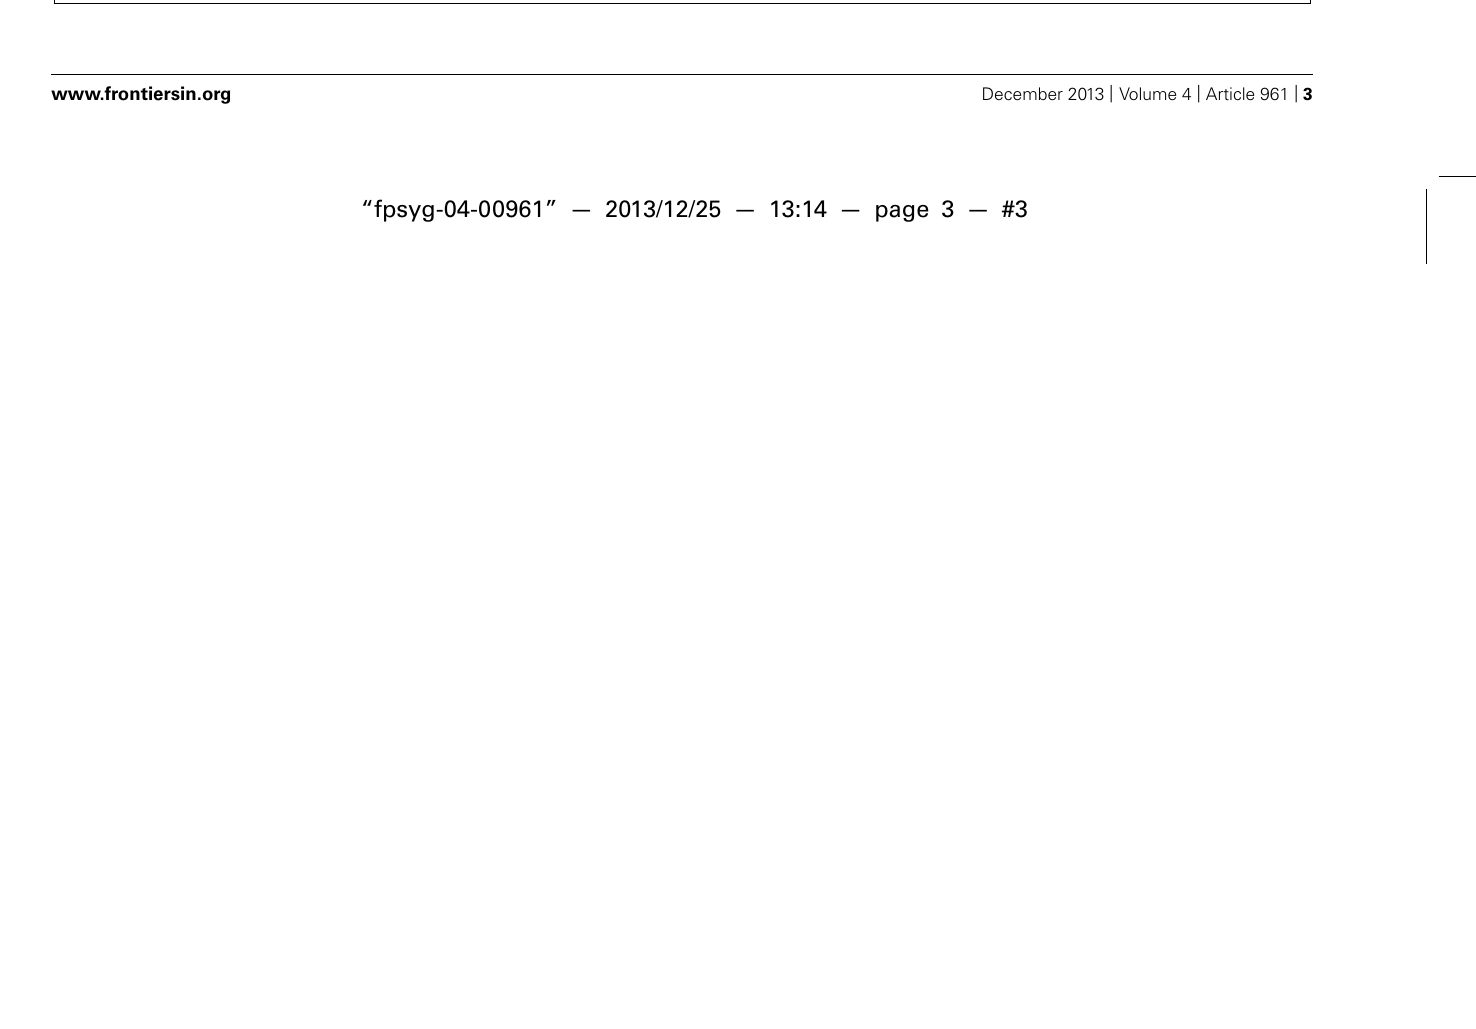
FIGURE 1 | Illustration of experimental procedure. Timeline of experimental procedure is illustrated – baseline measurements of behavioral tests (except for MW measurement) were collected from all participants before the fMRI-EEG scan. The fMRI-EEG functional scans